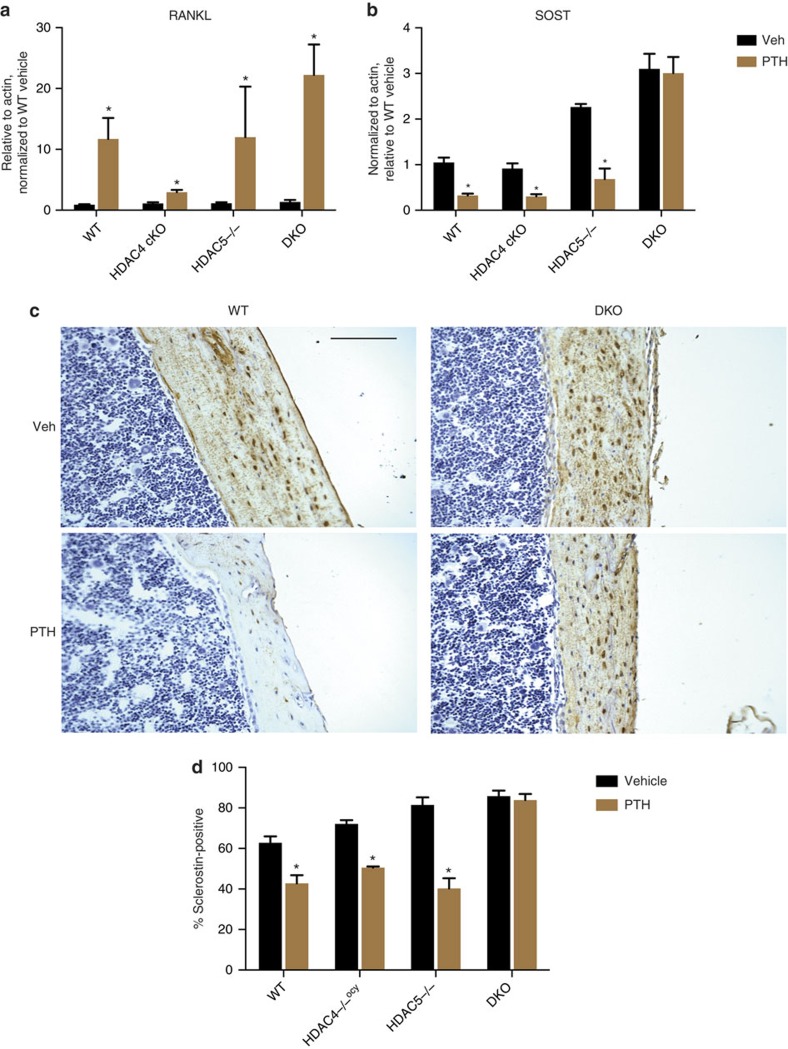
Class IIa HDACs are required for PTH-induced SOST suppression in vivo.(a,b) 6 week old male mice of the indicated genotype were treated with vehicle or PTH (1-34, 300 μg kg−1) and euthanized 90 min later. Bone RNA was obtained and RANKL and SOST transcript abundance was determined by RT-qPCR. * indicates P<0.05 comparing vehicle and PTH for each genotype. N=at least 6 mice per group were analysed. (c) Representative photomicrographs of sclerostin immunohistochemistry from WT and DKO mice treated with vehicle or PTH. Scale bar, 40 μm. (d) Quantification of immunohistochemistry results. Cortical osteocytes in a fixed region of bone 3 mm below the tibial growth plate were counted and scored as either sclerostin-positive or negative. N=6 mice per group were analyzed. * indicates P<0.01 comparing vehicle and PTH for each genotype by student's unpaired two tailed t-test.